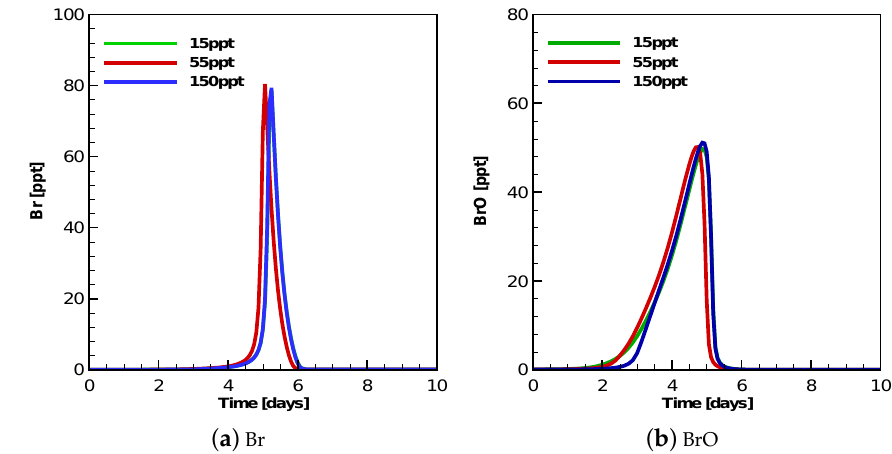
Figure 4. The evolution of ( a ) Br and ( b ) BrO under an initial NO (red curve) and 150ppt (blue